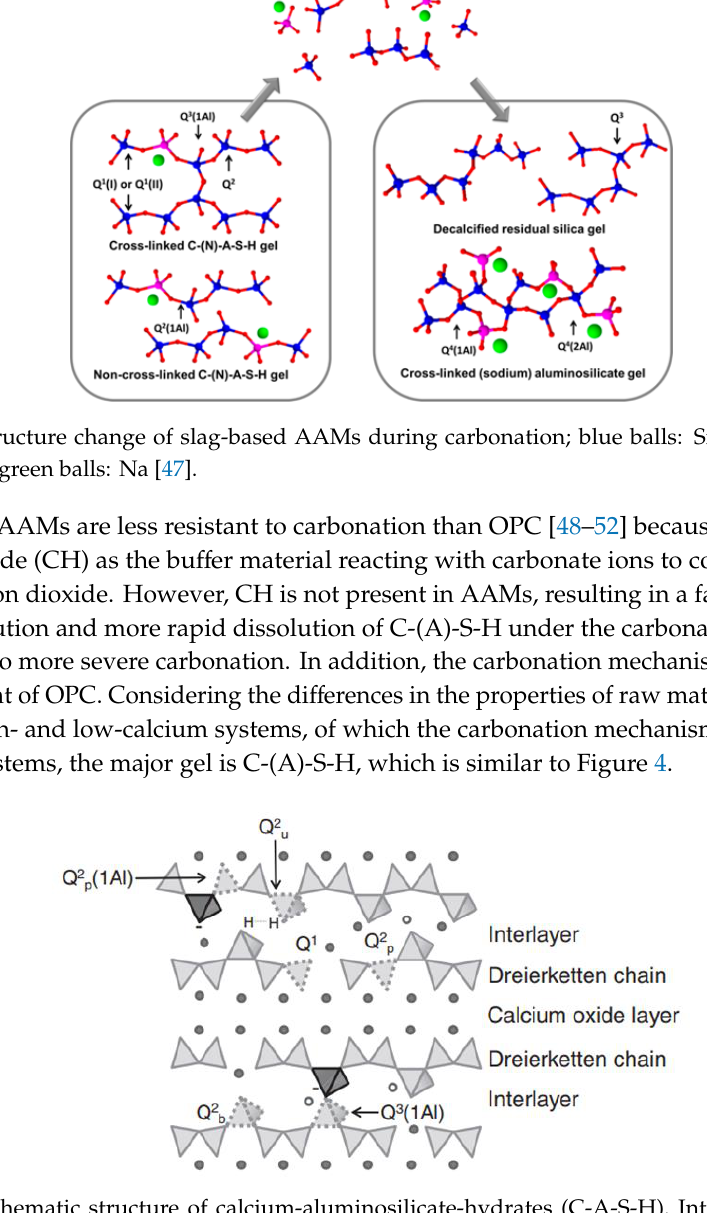
Figure 5. Schematic structure of sodium-aluminosilicate-hydrate (N-A-S-H) [48]. Its carbonation is mainly to reduce the high alkalinity and form sodium carbonate with a high concentration in the pore solution [55,56], but the structure of N-A-S-H gel does not change. In addition to alkali-activated precursors affecting the carbonation properties, different concentrations, types of alkali activators, and carbonation condition could also lead to different hydration products and carbonation properties [57]. 3.2. Factors Affecting Carbonation in AAMs 3.2.1. Type of Precursors Numerous investigations have found that the precursor composition in AAMs [58–64] has an obvious influence on the resistance to carbonation. This is mainly attributed to differences in the content of calcium, silicon, magnesium, and aluminum in the precursors and, thus, variations in the hydration products. Bernal et al. [65] found that the addition of metakaolin can increase the setting time of AAM paste and reduced susceptibility to carbonation. In another study, after accelerated carbonation for 540 h at the same humidity, an increased content of metakaolin in AAM concrete led to a reduction in carbonation depth [66], which was attributed to the fact that the addition of metakaolin increased